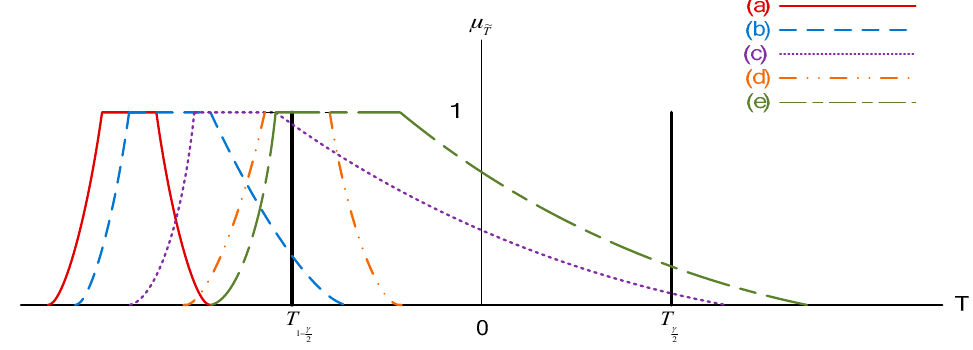
~ ~ ~ for the two-sided test. T for the two-sided test. for the two-sided test.